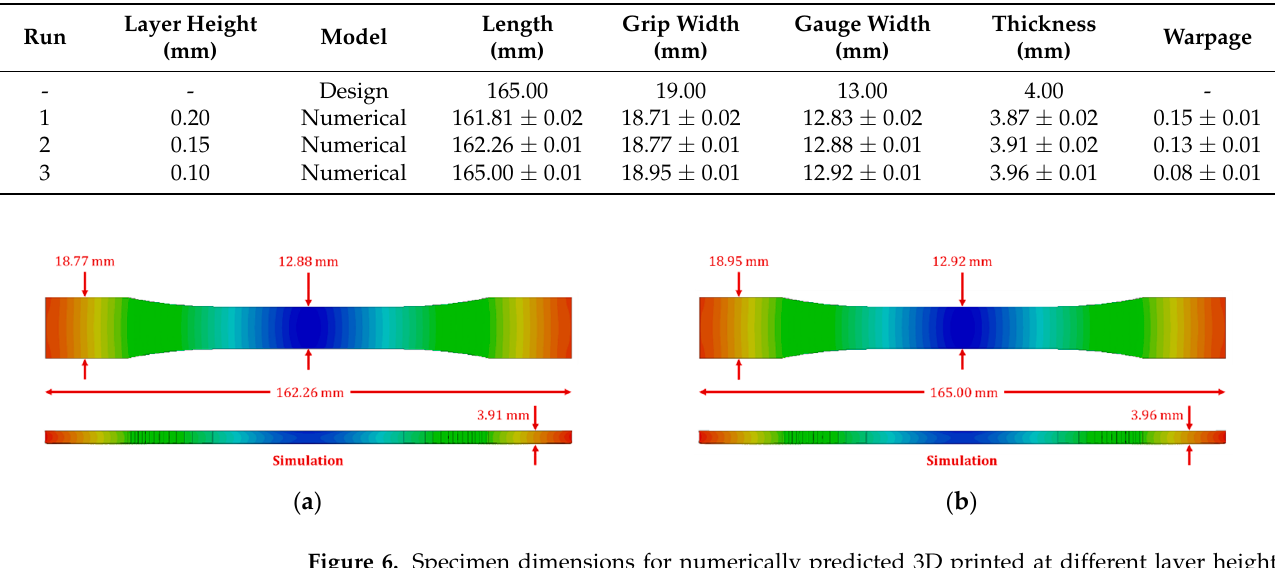
Table 2. Effect of Layer Height on Dimensional Variations in Numerical Model and 3DP Parts.